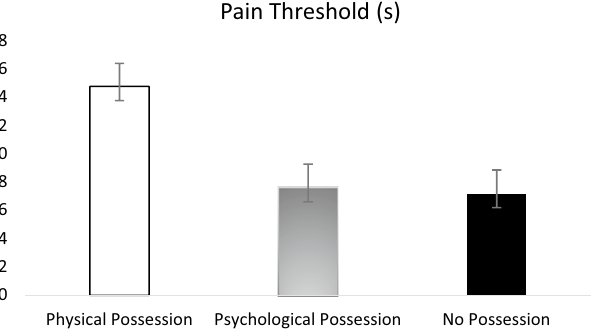
Figure 2. Main effect of possession condition on pain threshold. Participants in physical possession condition took longer to feel an initial pain sensation than participants in psychological possession condition and no possession condition. Error bars show 95% confidence intervals.